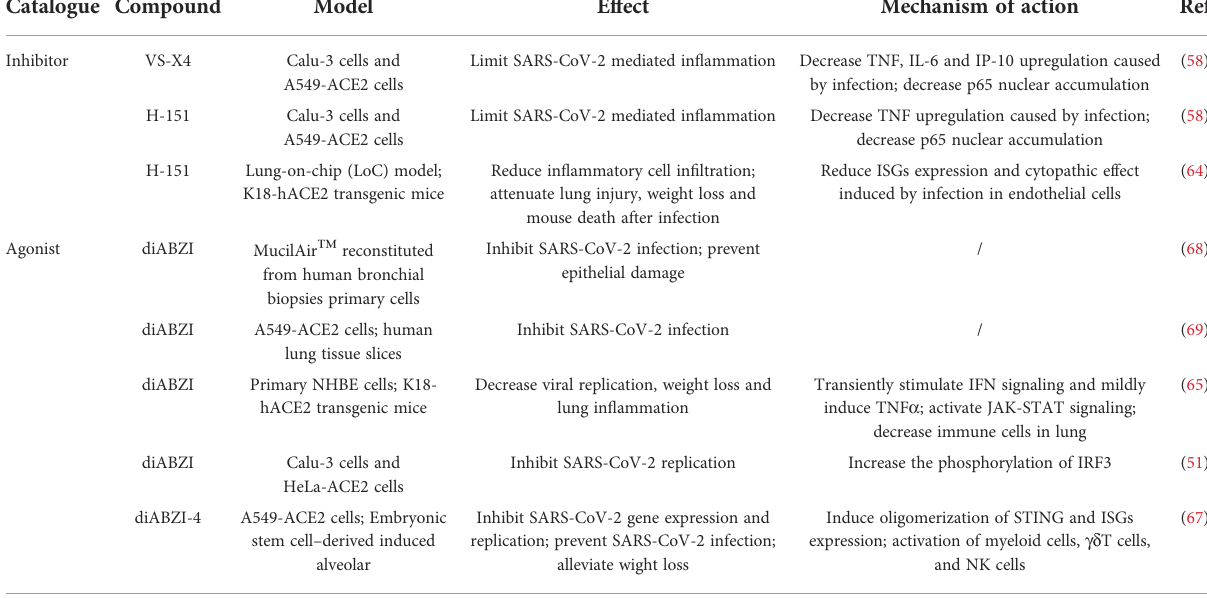
TABLE 2 The effect of STING inhibitors and agonists on